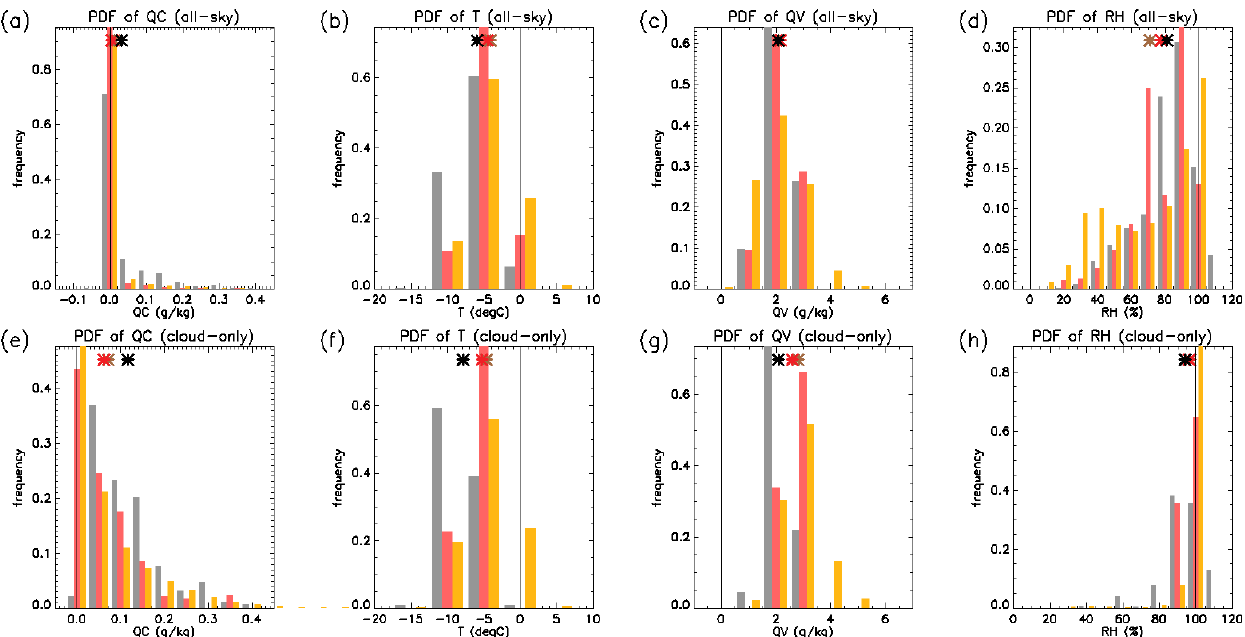
Figure 3. (a–d) PDFs of cloud and thermodynamic properties of the Arctic environment for ARISE (gray), the collocated values of ASR along the ARISE flight path (red), and the ASR values across the entire Beaufort Sea domain (orange). In addition, the mean values are indicated by the asterisks, with darker color shades corresponding to the data source (e.g., ARISE is black). Pane (a) shows the cloud water (liquid + ice) specific humidity (QC); (b) is temperature ( T ), (c) is water vapor specific humidity (QV), and (d) is relative humidity (RH). (e–h) Same as (a–d) , but for cloudy pixels only (i.e., pixels with mean QC > 0 . 02gkg − 1